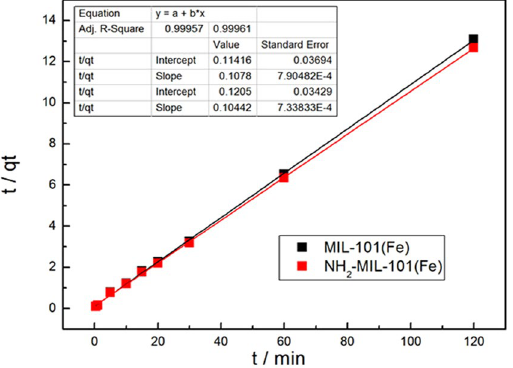
Figure 9. The pseudo second order kinetic equation fitting line of phosphate adsorption on Fe-based MOFs ( Adsorbents, 12 mg; NaH 2 PO 4 c 0 = 0.6 mg·L − 1 ; V = 0.2 L; T = 293 K).